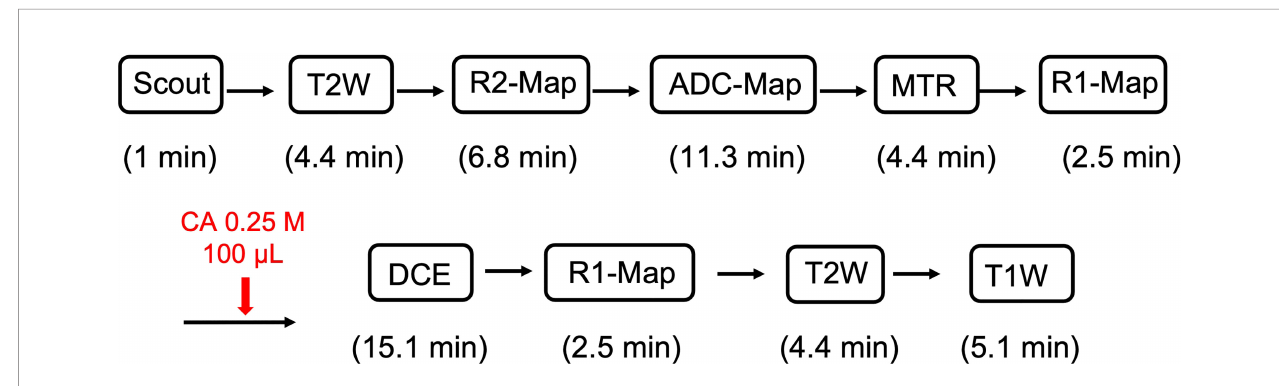
FIGURE 1 | Schematic of the 1 H MRI data acquisition